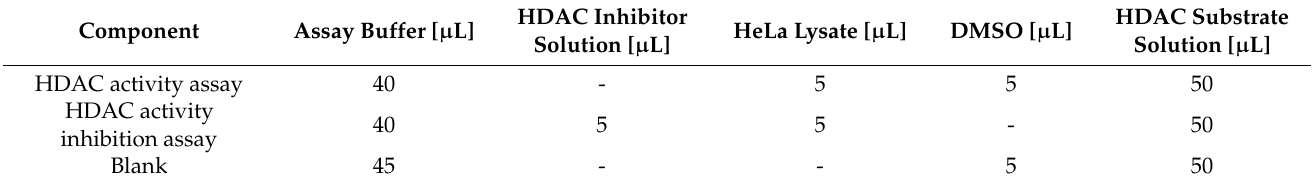
Table 6. Reaction Scheme for HDAC Activity.